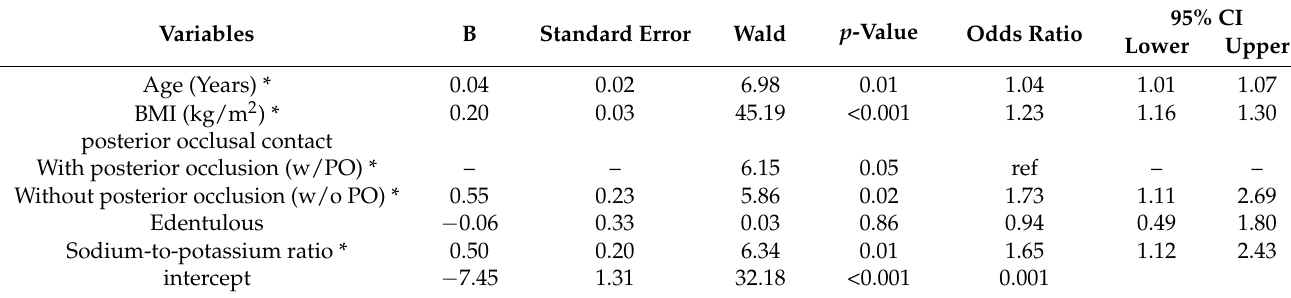
Table 5. Factors affecting